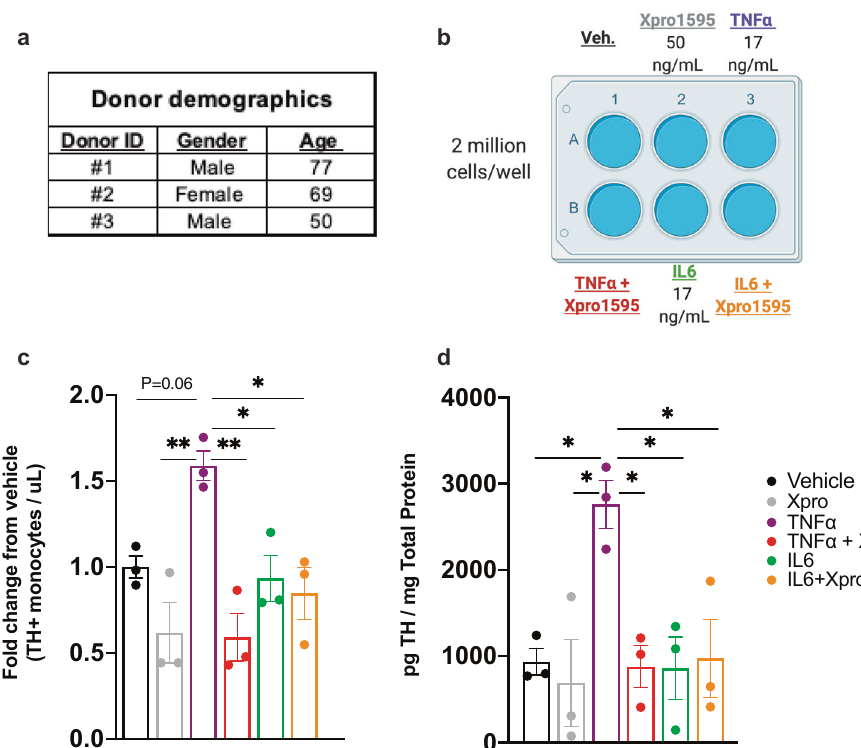
Fig. 7 Inhibition of TNF α blocks increase in number of TH + monocytes and amount of TH per monocyte. a and b Acutely isolated monocytes from three healthy donors were seeded at 2 million cells per well in duplicate ultra-low-adherence plates, and treated with TNF α (17 ng/mL), XPro1595 (50 ng/mL), IL6 (17 ng/mL) or combinations thereof as indicated. c In samples assayed by fl ow cytometry, using counting beads as a reference value to quantify the number of TH + cells, co-incubation with TNF α and XPro1595 signi fi cantly reduced the number of TH + monocytes relative to TNF α treatment alone. Treatment with IL6 or IL6 + XPro1595 resulted in no signi fi cant change in the number of TH + monocytes. Values are represented as fold change relative to vehicle ( n = 3 per group, one way ANOVA, * p < 0.05, ** p < 0.01). d TH concentration (picogram per milligram total protein) signi fi cantly increases upon TNF α treatment, and is reduced signi fi cantly to baseline levels following co-incubation with TNF α and XPro1595. Neither IL6 nor IL6 + XPro1595 signi fi cantly increased TH quantity ( n = 3 per group, one way ANOVA, * p < 0.05). Data are shown as